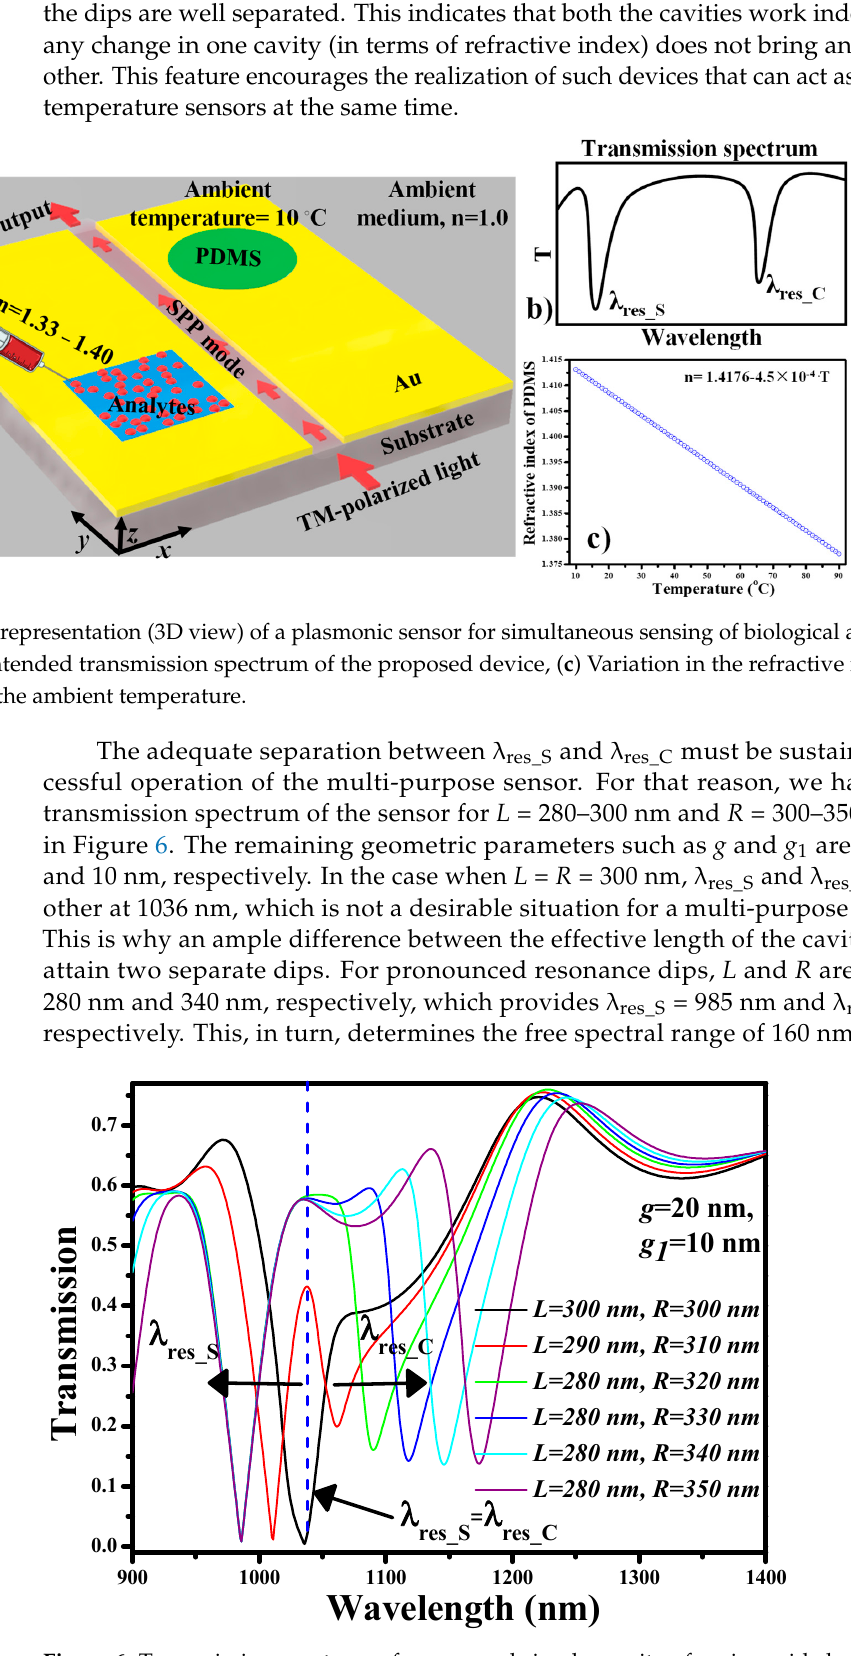
Figure 6. Transmission spectrum of square and circular cavity of various side lengths. The dotted blue line indicates the overlapping of λ res_S and λ res_C .